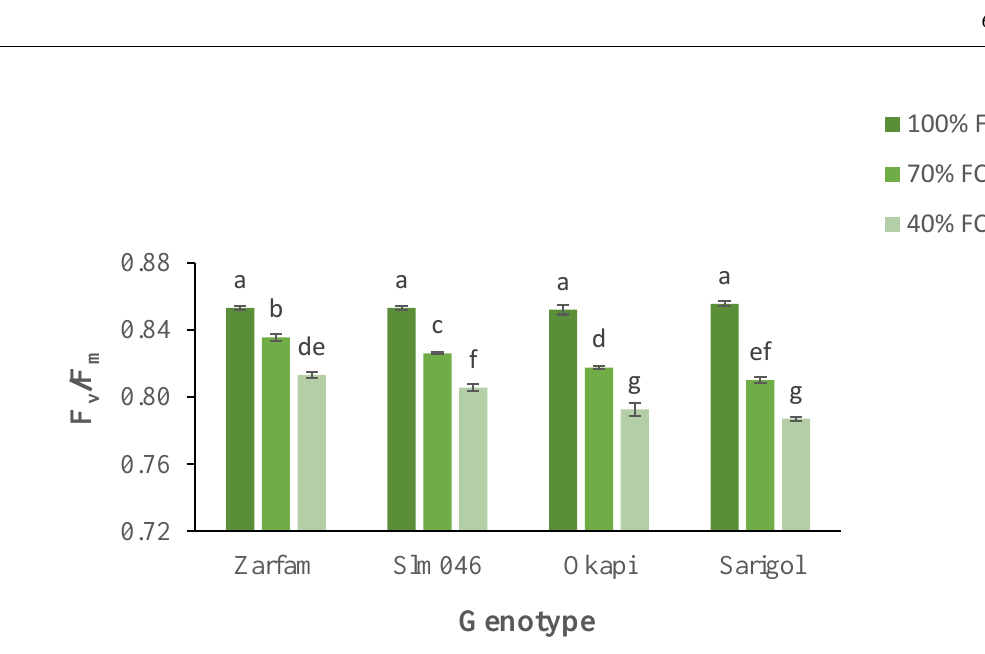
Figure 3. Interaction effect of drought stress and genotype on the maximum quantum yield (F v /F m ) of canola leaves. Data are means ( n = 3) ± SE. Different letters indicate differences ( p < 0.05) among treatments according to the Duncan test.